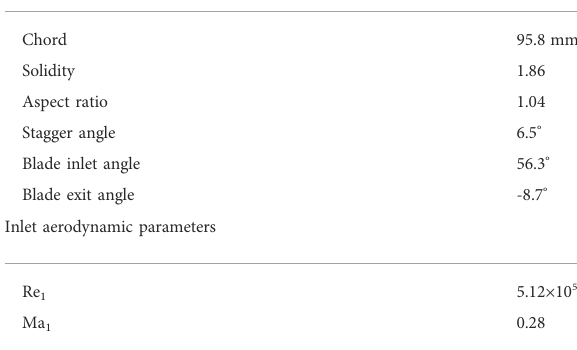
TABLE 1 Compressor cascade geometry and inlet aerodynamic parameters. Blade